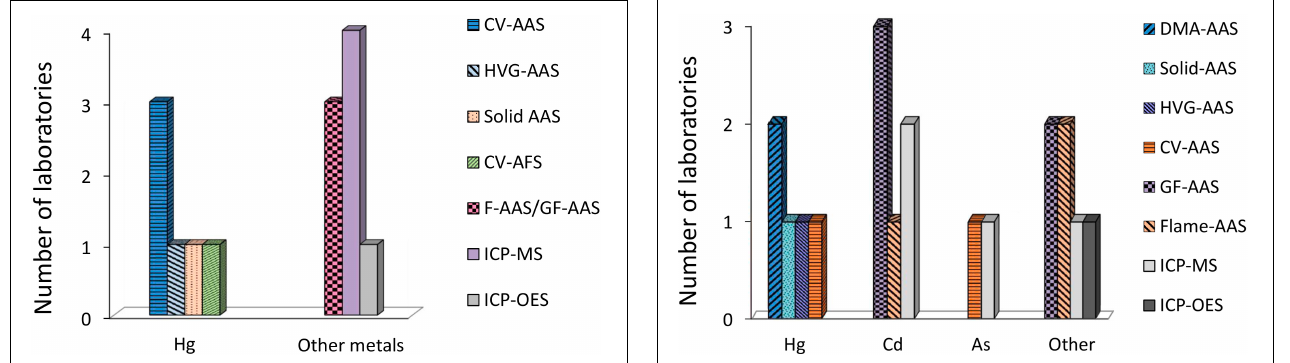
Fluorescence Spectrometry; F-AAS, Flame Atomic Absorption Spectrometry; GF-AAS, Graphite Furnace Atomic Absorption Spectrometry; CP-MS, Inductively Coupled Plasma Mass Spectrometry; ICP-OES, Inductively Coupled Plasma Optical Emission Spectrometry.